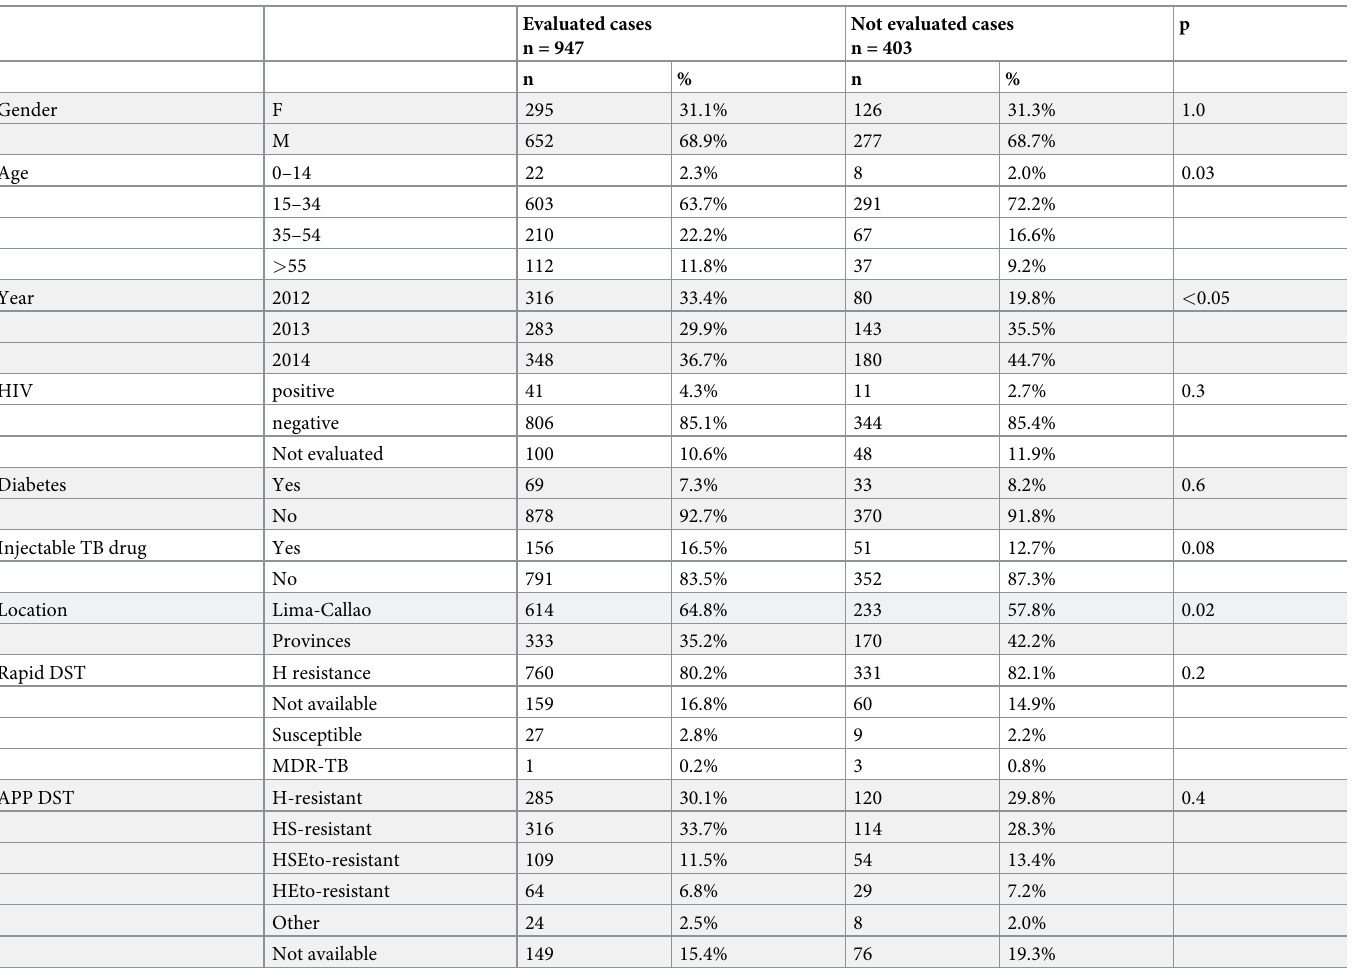
Table 1. Characteristics of evaluated and not evaluated